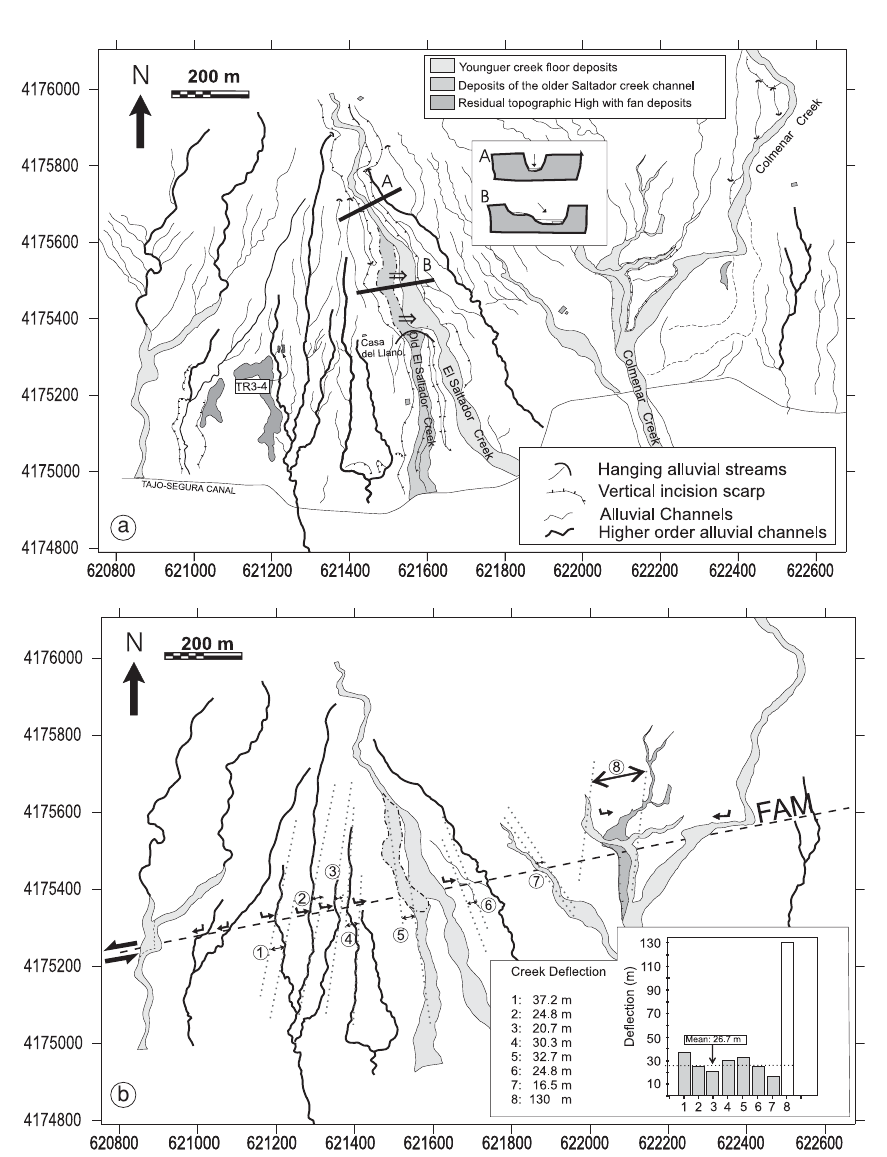
Fig. 6a,b. Geomorphic map of the alluvial network on the El Saltador fan mapped at the 1:5000 scale. a) Complete drainage network along with main morphological features. Darkest grey colour shows the relict topographic high in the hanging wall of the SAMF (see fig. 4a,b). Intermediate grey colour shows the old El Saltador Creek chan- nel before the capture triggered by the headward erosion in the hanging wall. Topographic sections A and B show the asymmetric entrenching of the creek near the fault driven by the capture. Light grey colour represents modern channels. b) The higher order channels are represented together with the fault trace. We measured the systematic left-lateral deflections of the channels crossing the SAMF. The histogram shows the component parallel to the fault of the deflections. Only the grey bars were used to calculate the mean value of